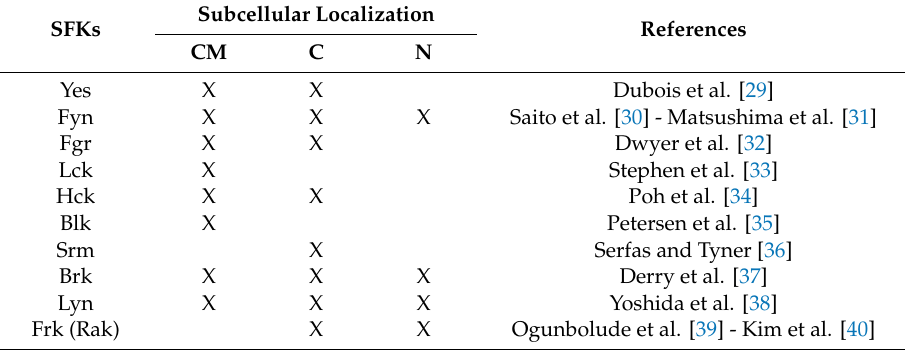
Table 1. Subcellular distribution of Src-family kinases (SFKs) other than Src. CM: cell membrane; C: cytoplasm; N: